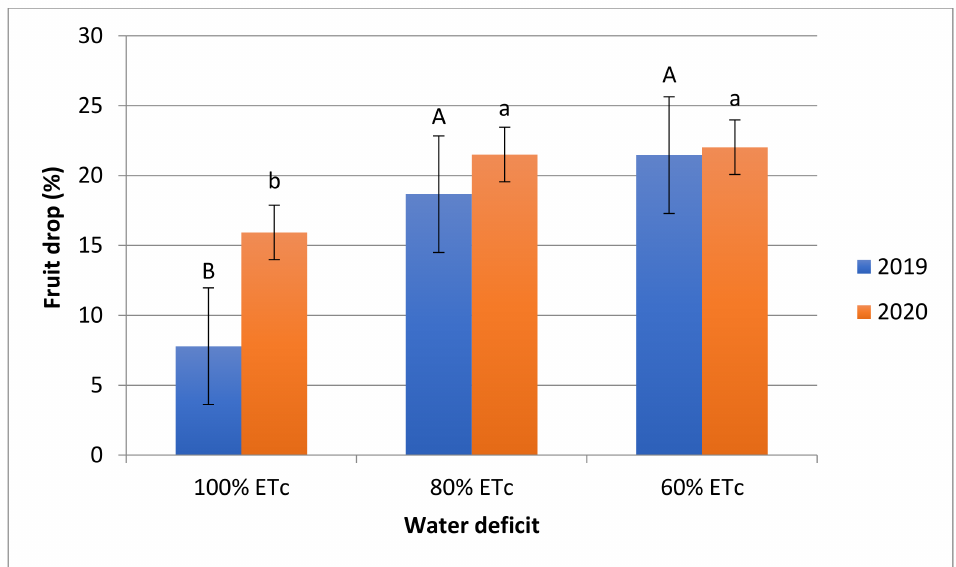
Figure 2. Effect of deficit irrigation (as a percentage of crop evapotranspiration, ETc) on the ‘African Rose’ plum fruit drop percentage during the 2019 and 2020 seasons. Standard error bars and Duncan’s multiple range test (DMRT) were used for mean comparisons within the same year ( n = 10). Capital and small letters represent DMRT for 2019 and 2020, respectively.